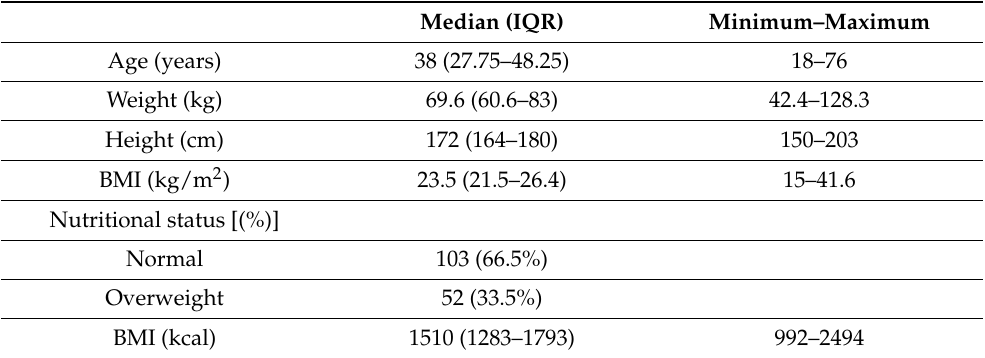
Table 2. Body measurements and composition.